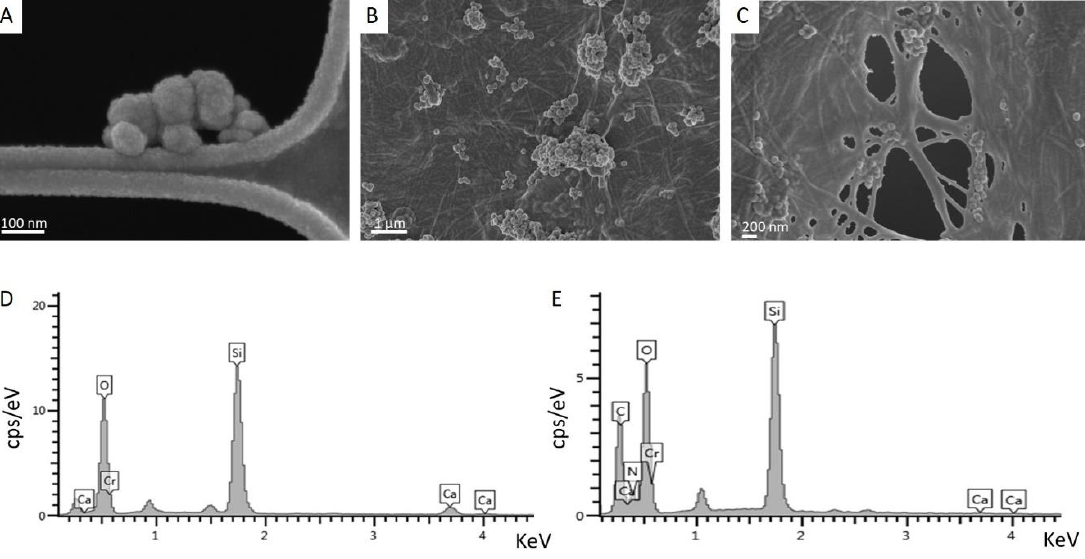
Figure 2. Field-emission scanning electron microscopy (FESEM) images of MBG_Sr4% particles ( A ) and Coll / MBG_Sr4% samples ( B , C ); energy-dispersive X-ray spectroscopy (EDS) analyses showing the composition of MBG_Sr4% ( D ) and Coll / MBG_Sr4% system ( E ).